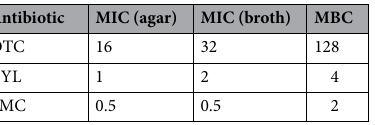
Table 1. Susceptibility of M. plutonius 2019BC1 to antibiotics